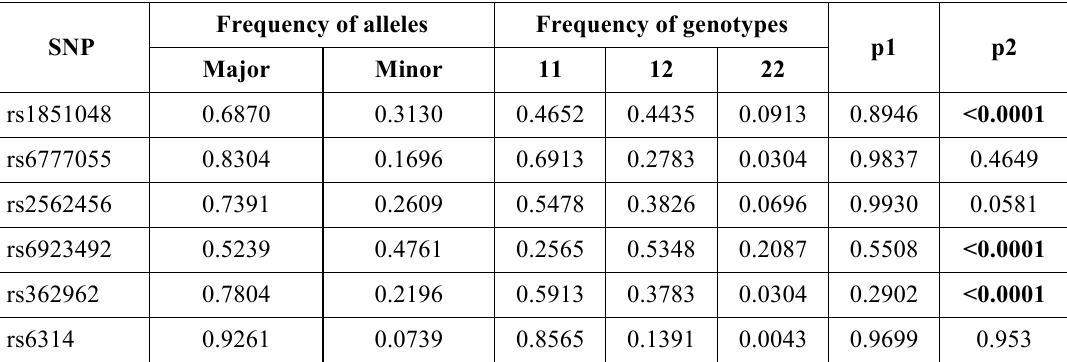
Table 3: Distribution of alleles and genotypes in the studied population.